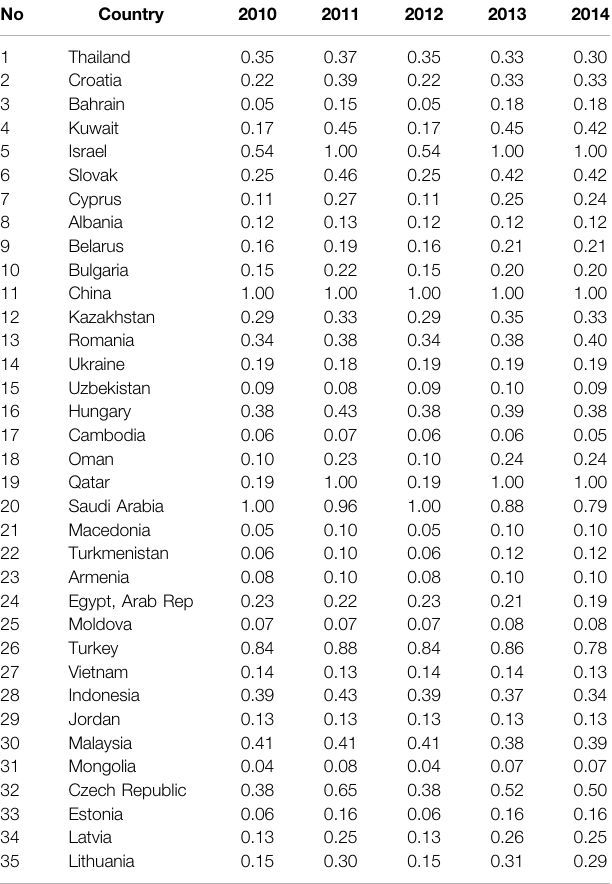
TABLE 2 | Energy ef fi ciency